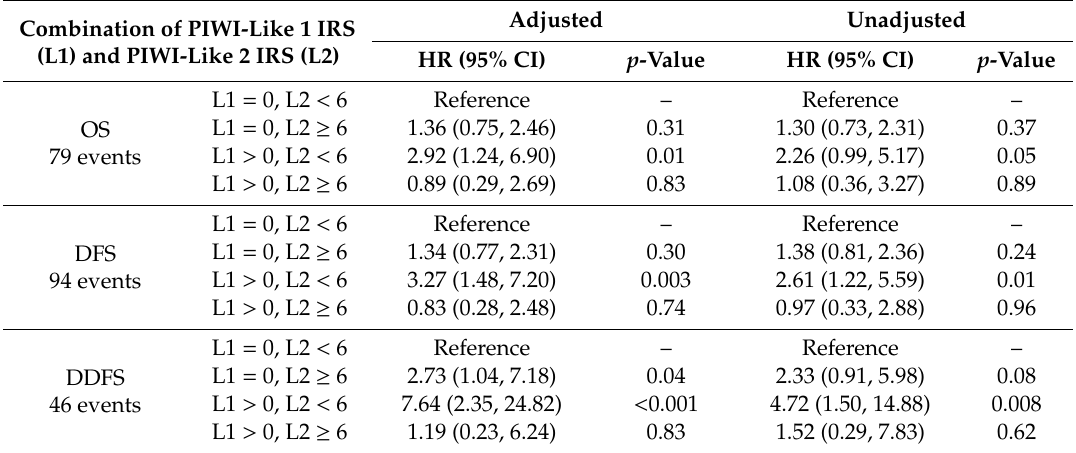
Table 2. Adjusted and unadjusted hazard ratios (HR) and 95% confidence intervals (CIs) for the four combinations of PIWI-Like 1 IRS and PIWI-Like 2 IRS. Combination of PIWI-Like 1 IRS